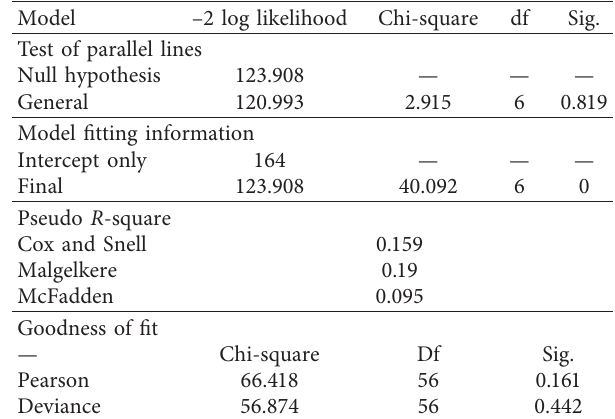
Table 5: Details of the regression